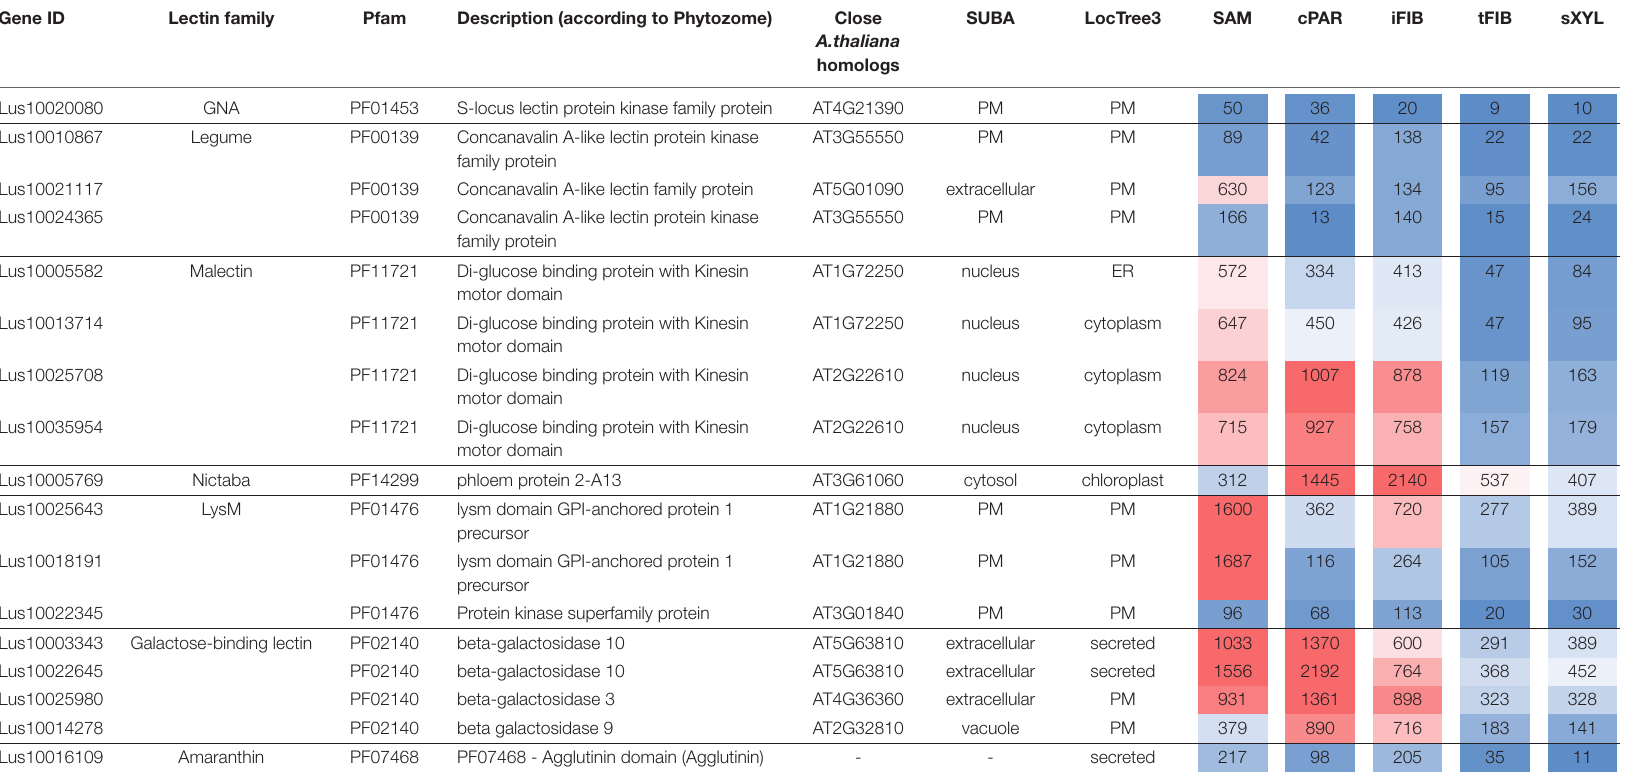
TABLE 3 | Linum usitatissimum genes encoding proteins with lectin domains upregulated in flax stem tissue samples with the primary cell wall. Gene